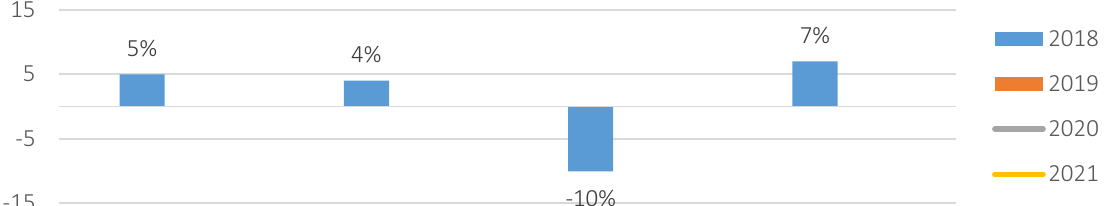
Figure 3. Global transportation and logistics sector performance and expectation for 2021